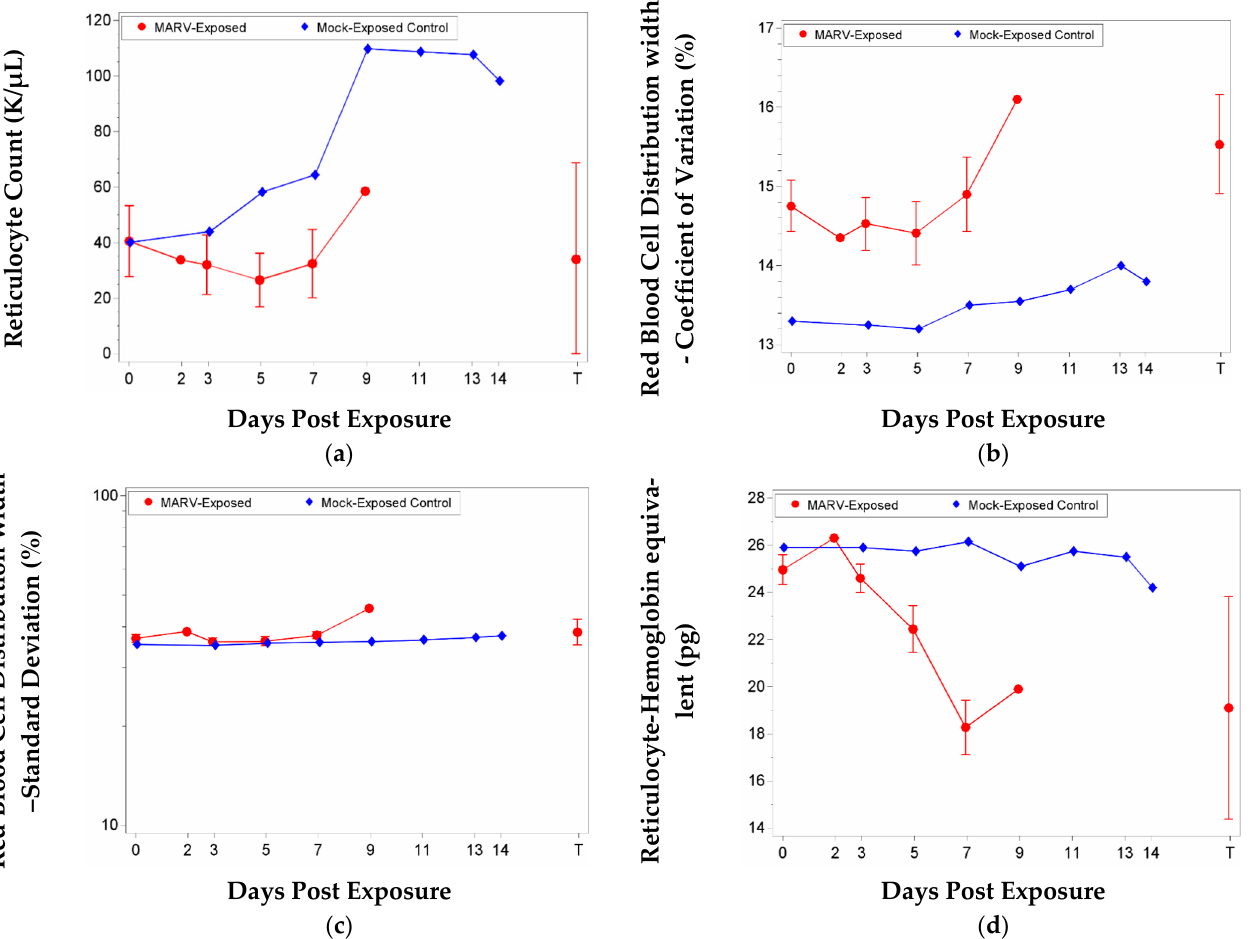
Figure 4. Mean with 95 percent confidence intervals for red ‐ blood ‐ cell ‐ related parameters. Confidence interval was not plotted for sample size less than 3. Unless otherwise noted, values were not log ‐ transformed; arithmetic mean displayed. Terminal (T)—Terminal data collected from animals that met euthanasia criteria (unscheduled euthanasia) were combined and reported as a single time point. ( a ) Reticulocyte counts; ( b ) Red Blood Cell Distribution width—Coefficient of Variation; ( c ) Red Blood Cell Distribution width—Standard Deviation (RDW ‐ SD); values for this parameter were log ‐ transformed, and the geometric mean is displayed; ( d ) Reticulocyte hemoglobin equivalent.